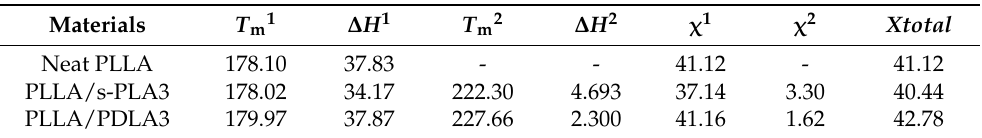
Table 2. Thermal properties evaluation by Differential Scanning Calorimeter with scanning speed 10 ◦ C/min.